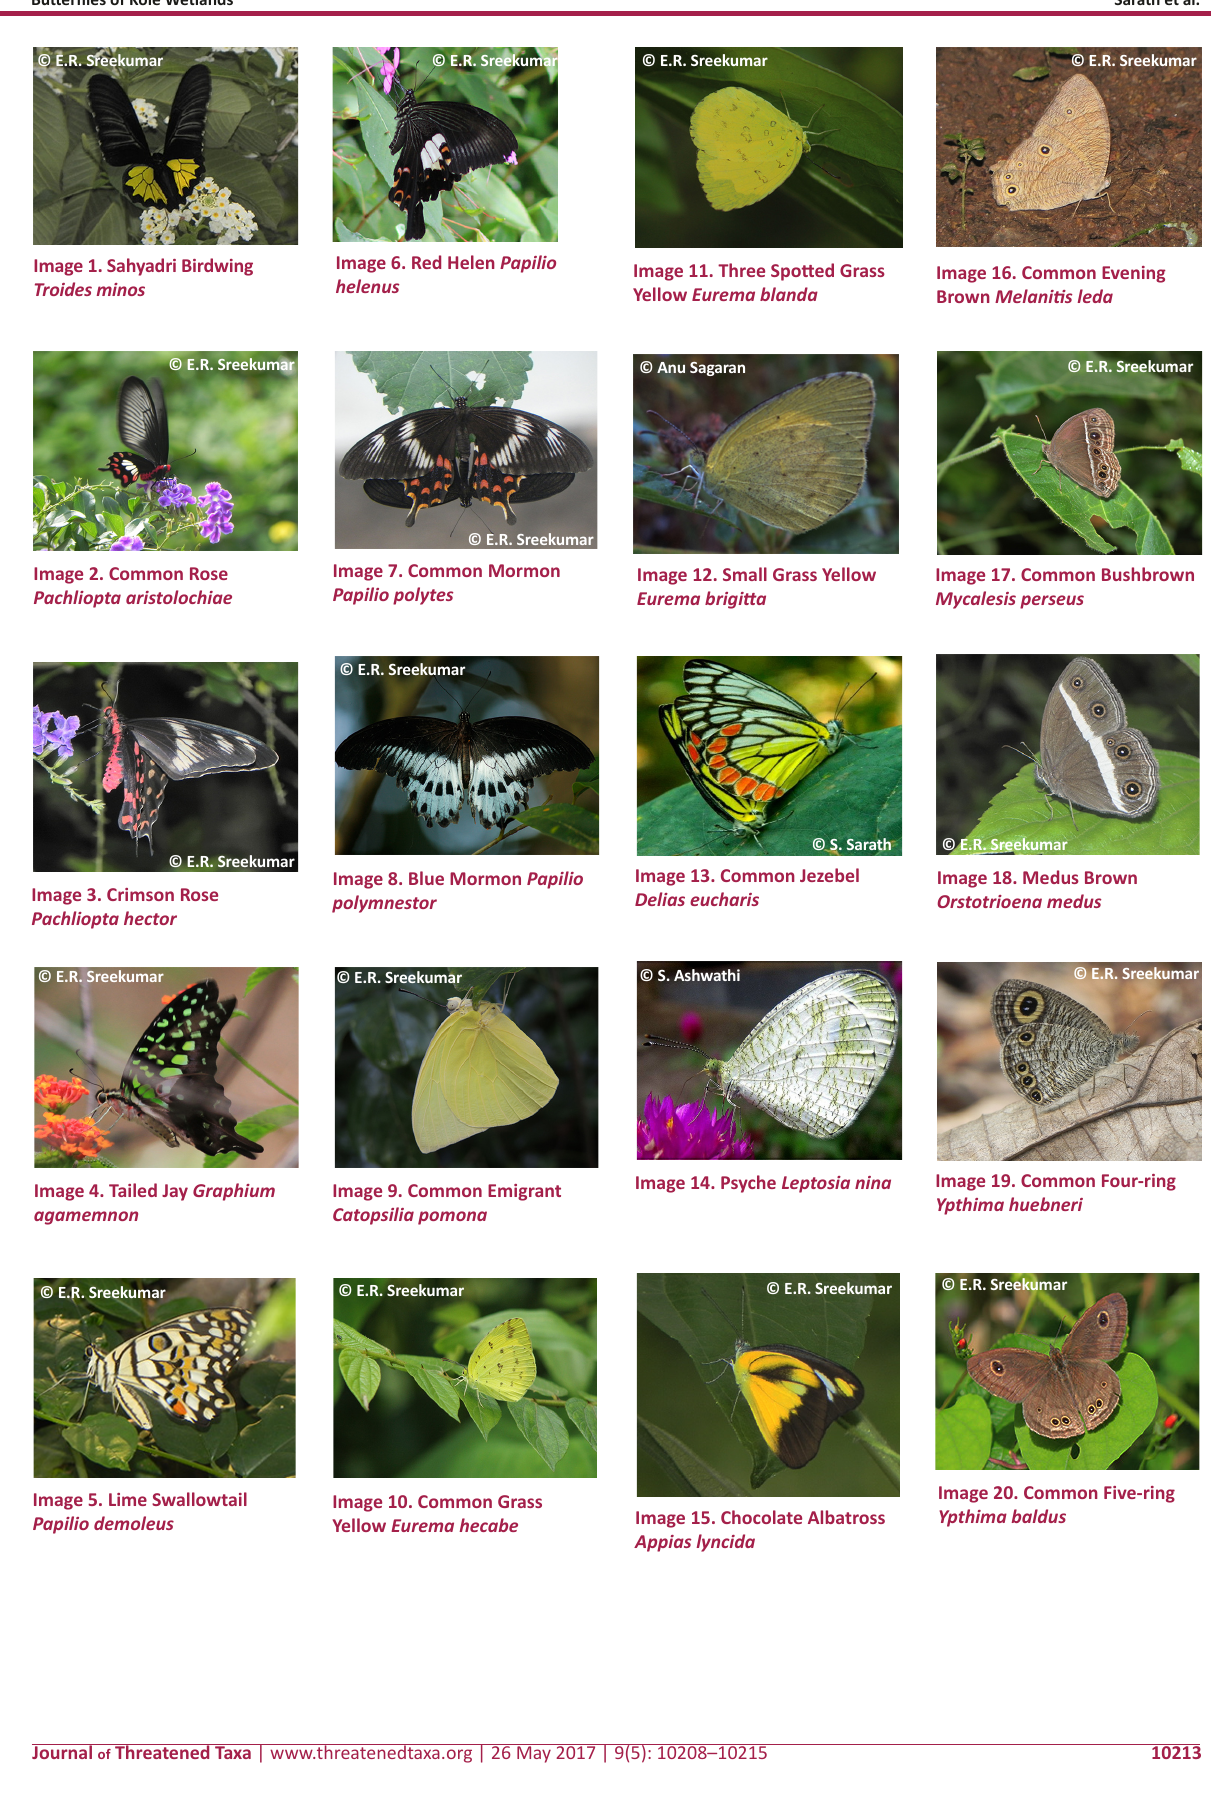
Image 15. Chocolate Albatross Appias lyncida